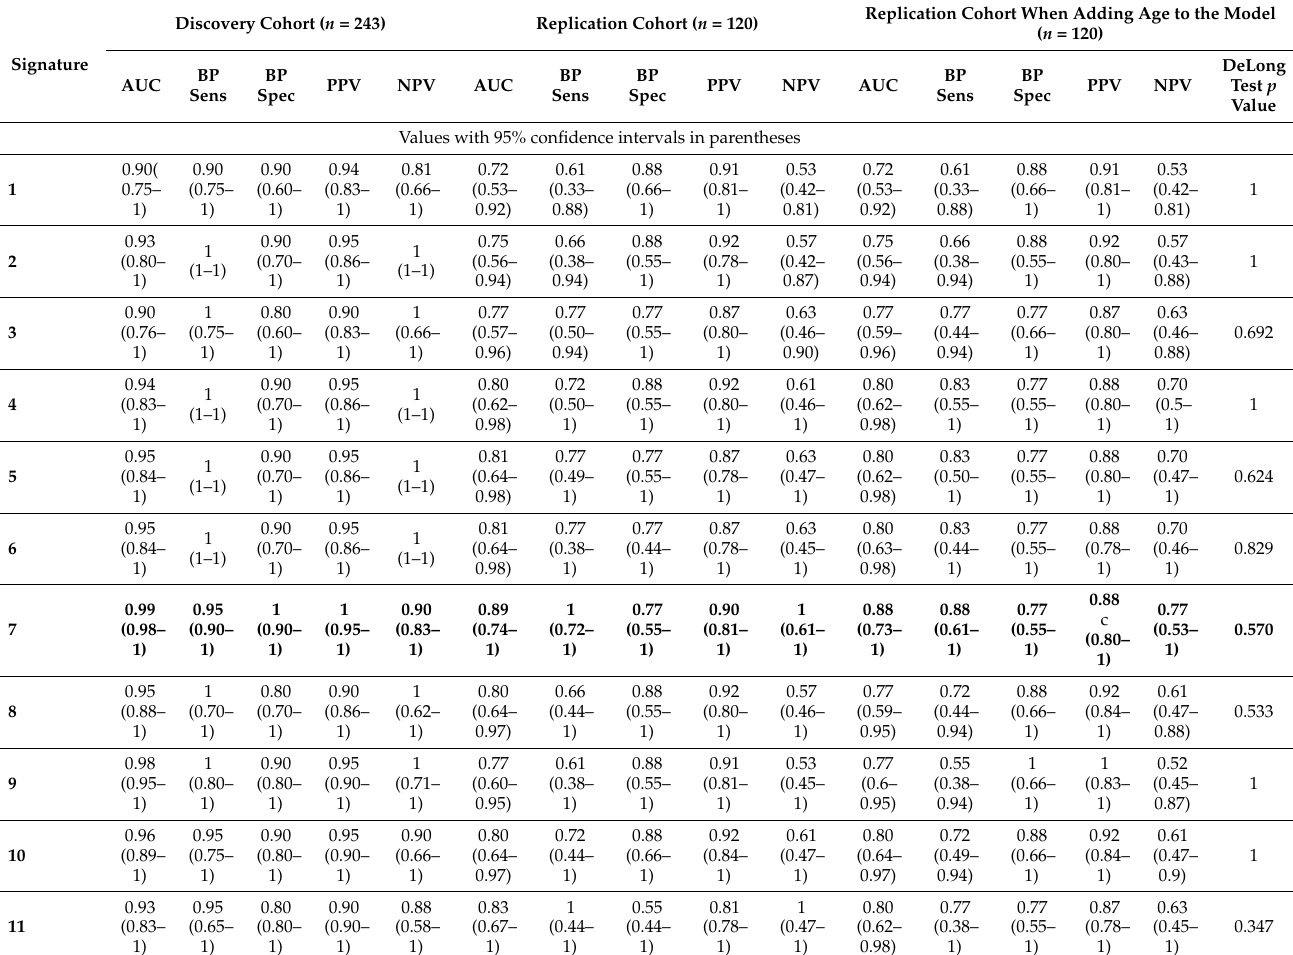
Table 3. Performance of the candidate prognostic protein signatures for Index